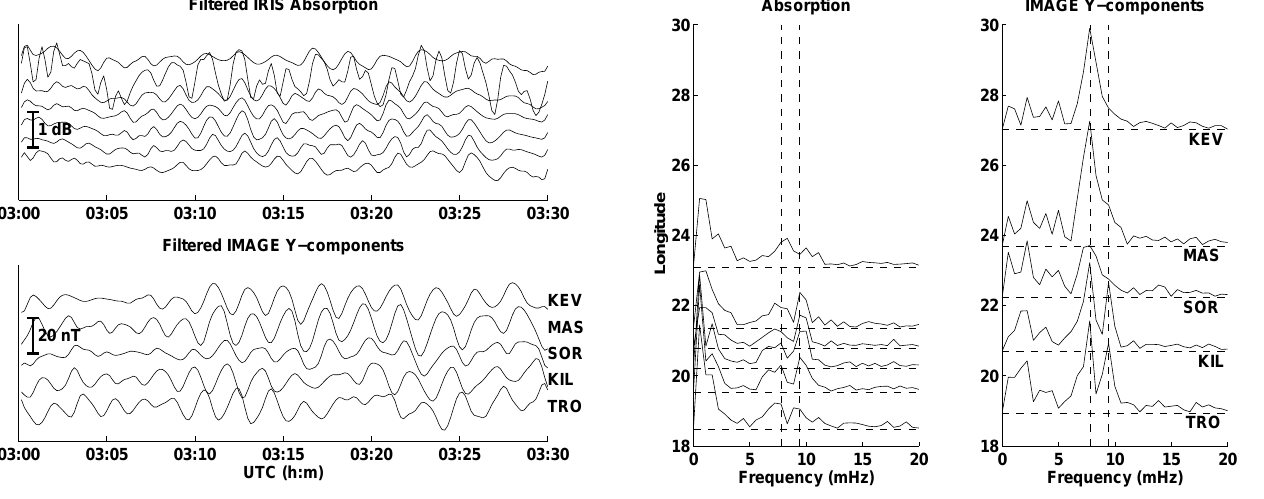
Fig. 6. Spectra of Event 2 in absorption and Y -component. The ver- tical dashed lines indicate frequencies of 7.8 and 9.4 mHz. The hor- izontal dashed lines indicate the baselines of each spectrum. These have been placed at the longitude of the corresponding IRIS beam or magnetometer. The spectrum of the IRIS beam affected by scin- tillation has been